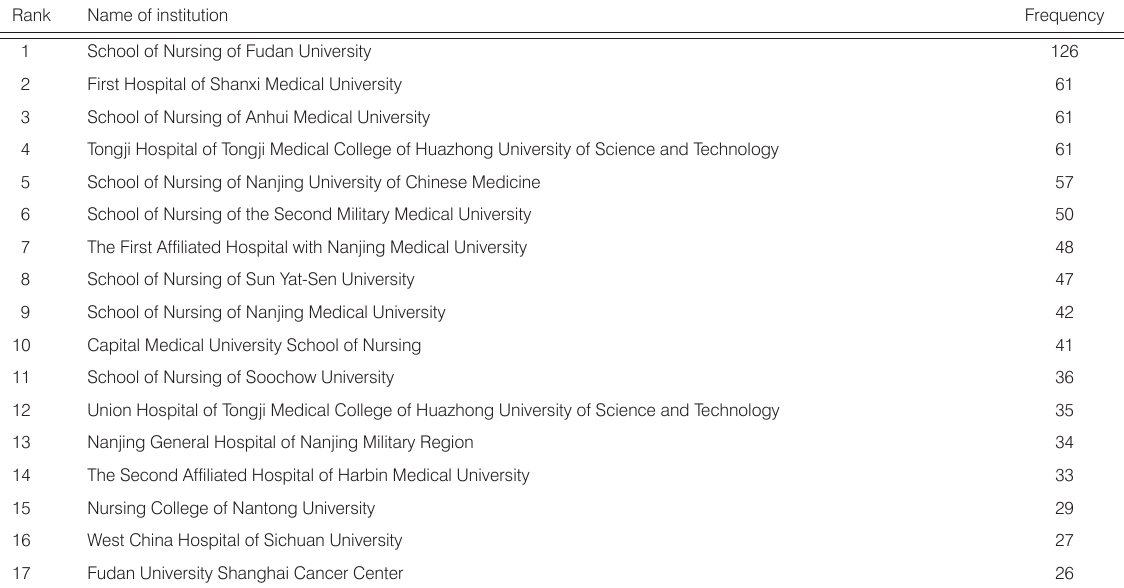
Table 1. Statistics of publication frequencies of